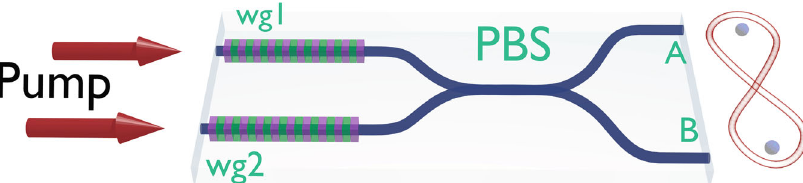
Fig. 1 Chip scheme: two periodically poled waveguides produce orthogonally polarized photons via type II parametric down conversion. The pairs are split on an integrated polarizing beam splitter (PBS) such that the output state is | H A , V B 〉 ( | V A , H B 〉 ) when the pair is generated in waveguide wg1 (wg2). The superposition of these two contributions results in the desired entangled